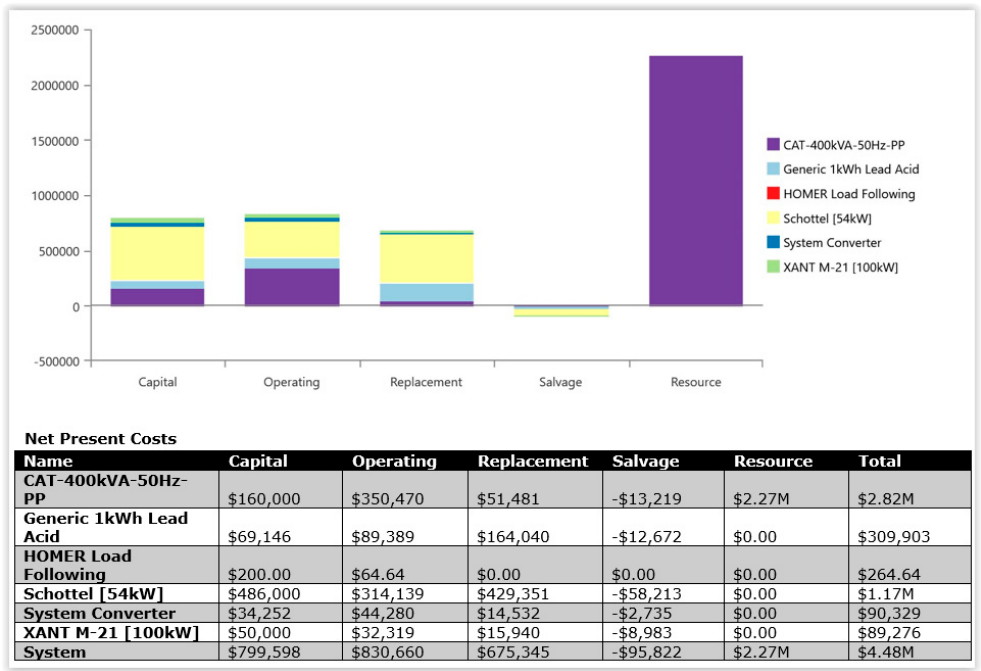
Figure 18. Cost and summary results and components of NPC for balanced alternative scenario (1W + 10T).